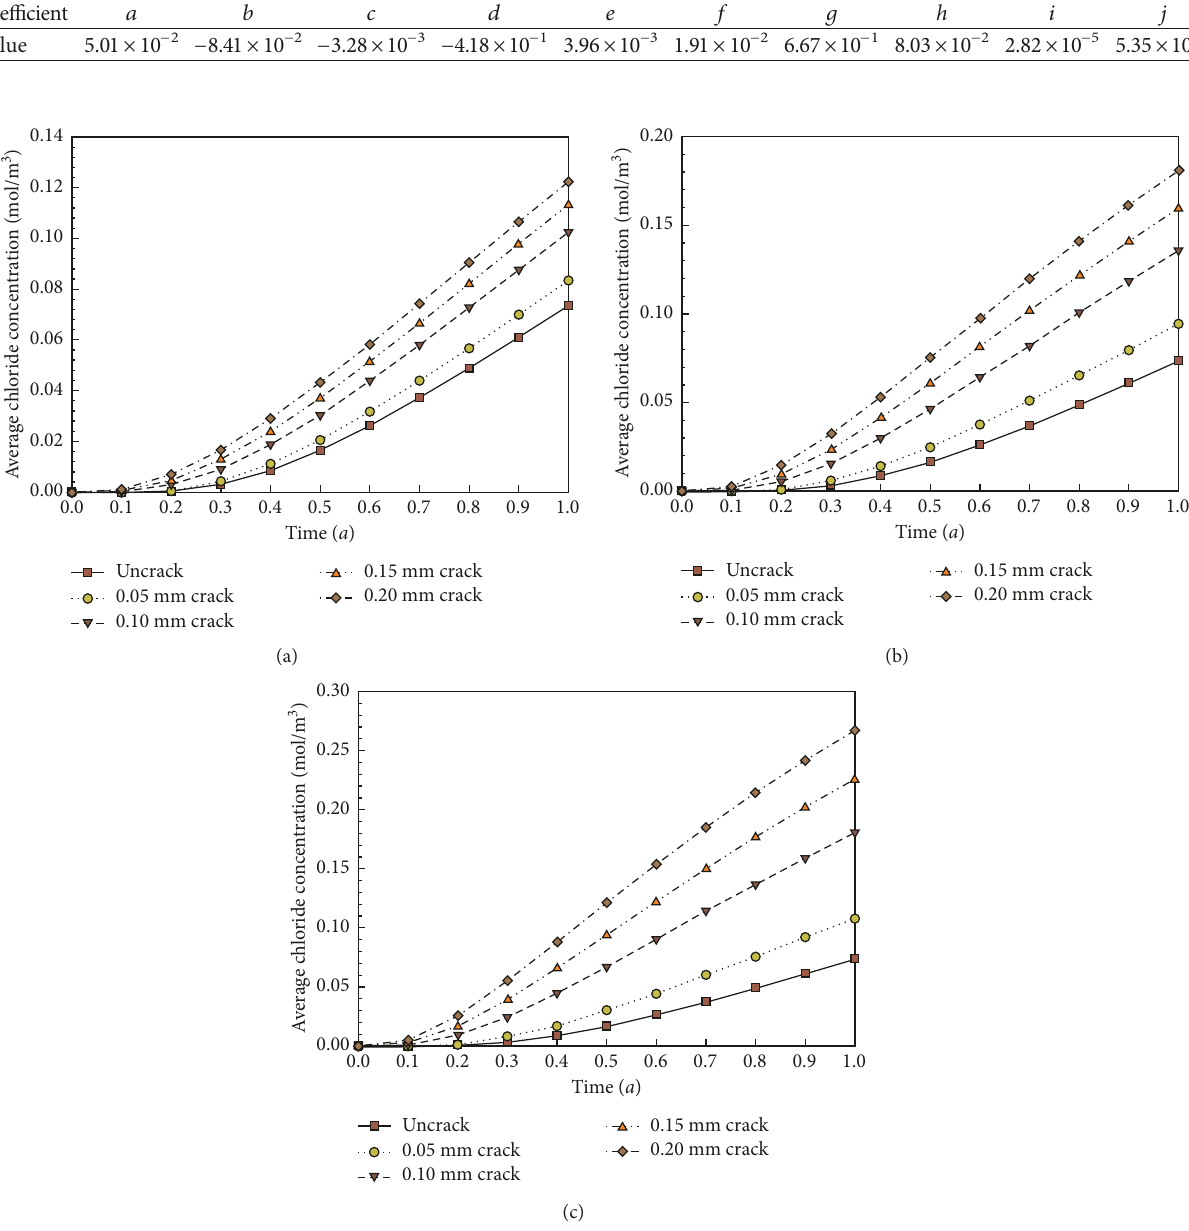
Table 5. Based on Table 5, the curves of average chloride concentration on the simulated surface of the rebar related to different crack widths and frequencies are shown in cracks on rebar corrosion.